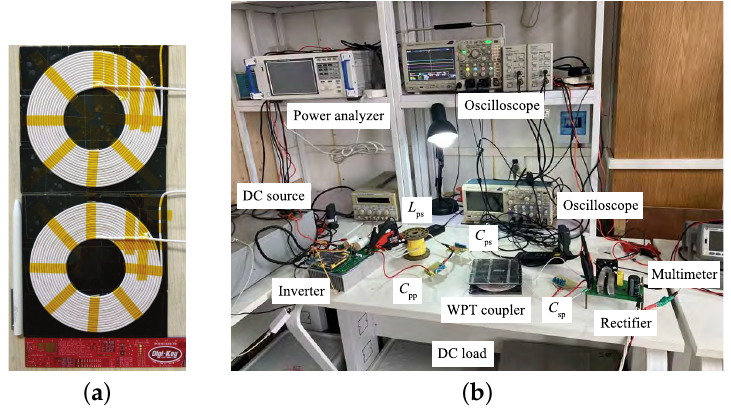
Figure 10. ( a ) The designed IPT coupler and ( b ) experimental